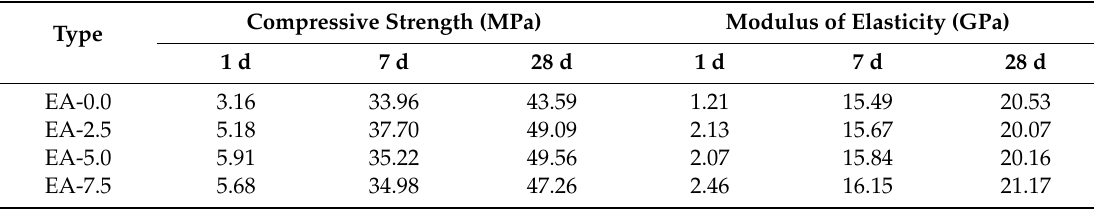
Table 3. Compressive strength and modulus of elasticity of AAM